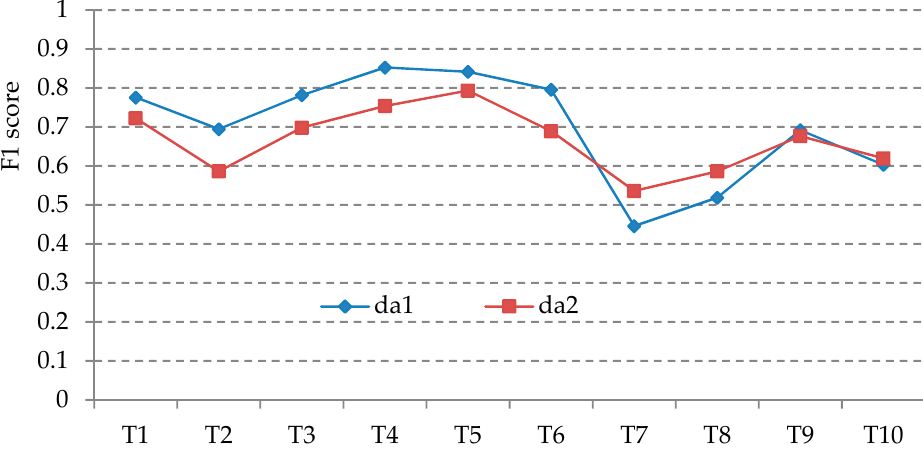
Figure 17. Average F1 scores of 18 models for 10 test areas with and without data augmentation.